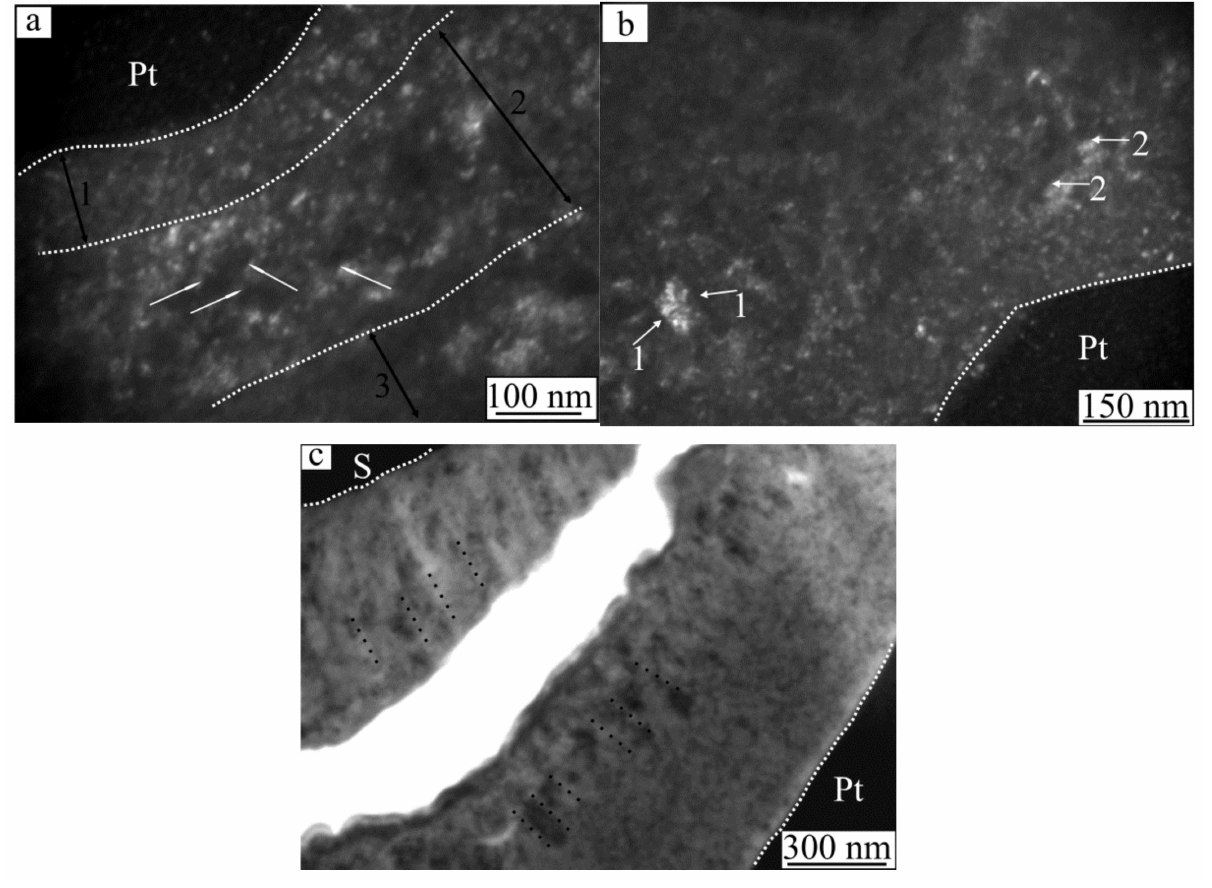
Figure 8. Dark-field ( a , b ) and bright-field ( c ) images of the microstructure in the indented region. Notations in ( a ): 1—nanocrystalline layer, 2—columnar layer, 3— α -Ti sublayer. Notations in ( b ): 1— inclined boundaries of columnar grains, 2—misorientation boundaries that are perpendicular to the loading axis. Notations in ( c ): S—substrate, dotted lines denote the boundaries of columnar crystals in different parts of the coating.